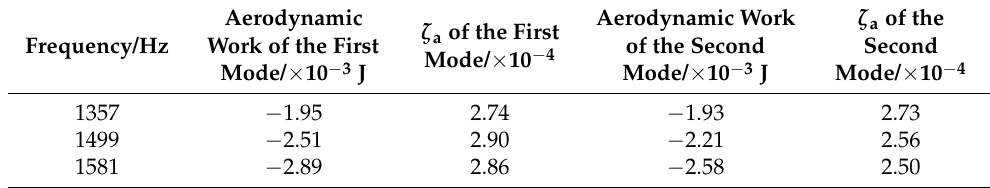
Table 5. Aerodynamic work and ζ a of the first and second modes with three typical frequencies.